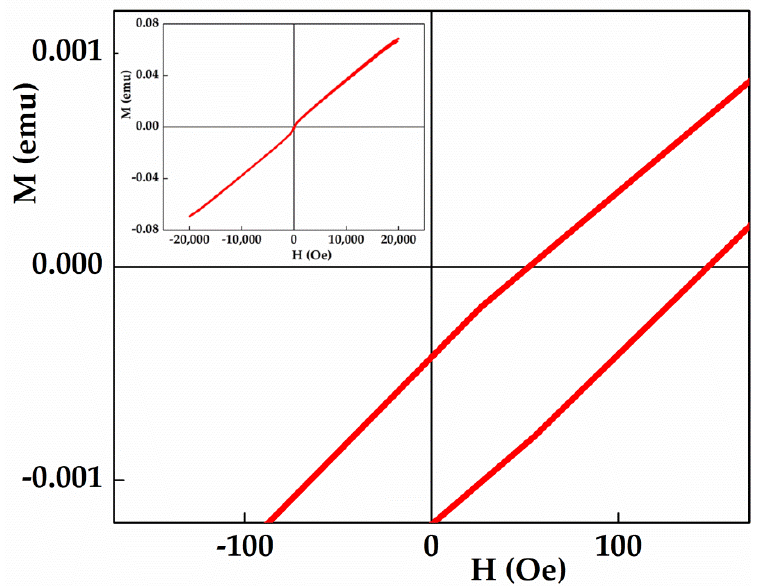
Figure 6. Enlargement of the low magnetic field region of the hysteresis loop measured at room temperature. The inset shows the corresponding hysteresis cycle. Table 1. Comparison of the obtained physical properties of Ni 51.82 Mn 32.37 In 15.81 ribbons with earlier reports.